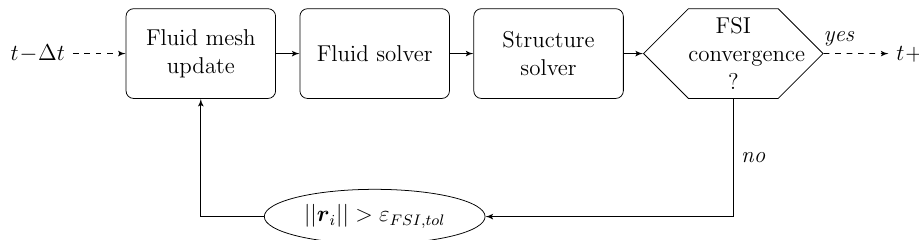
Figure 3. FSI implicit coupling scheme.